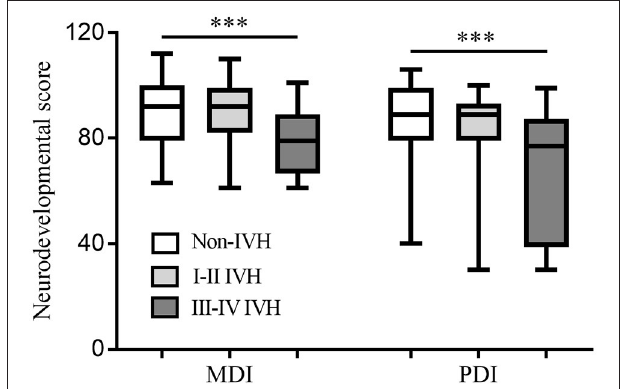
FIGURE 2 | Neurodevelopmental score at 18–24 months of corrected age among the groups. Both MDI and PDI values were significantly lower in the infants with grade III-IV IVH compared to those without IVH. No significant differences were observed between the grade I-II IVH group and the non-IVH.